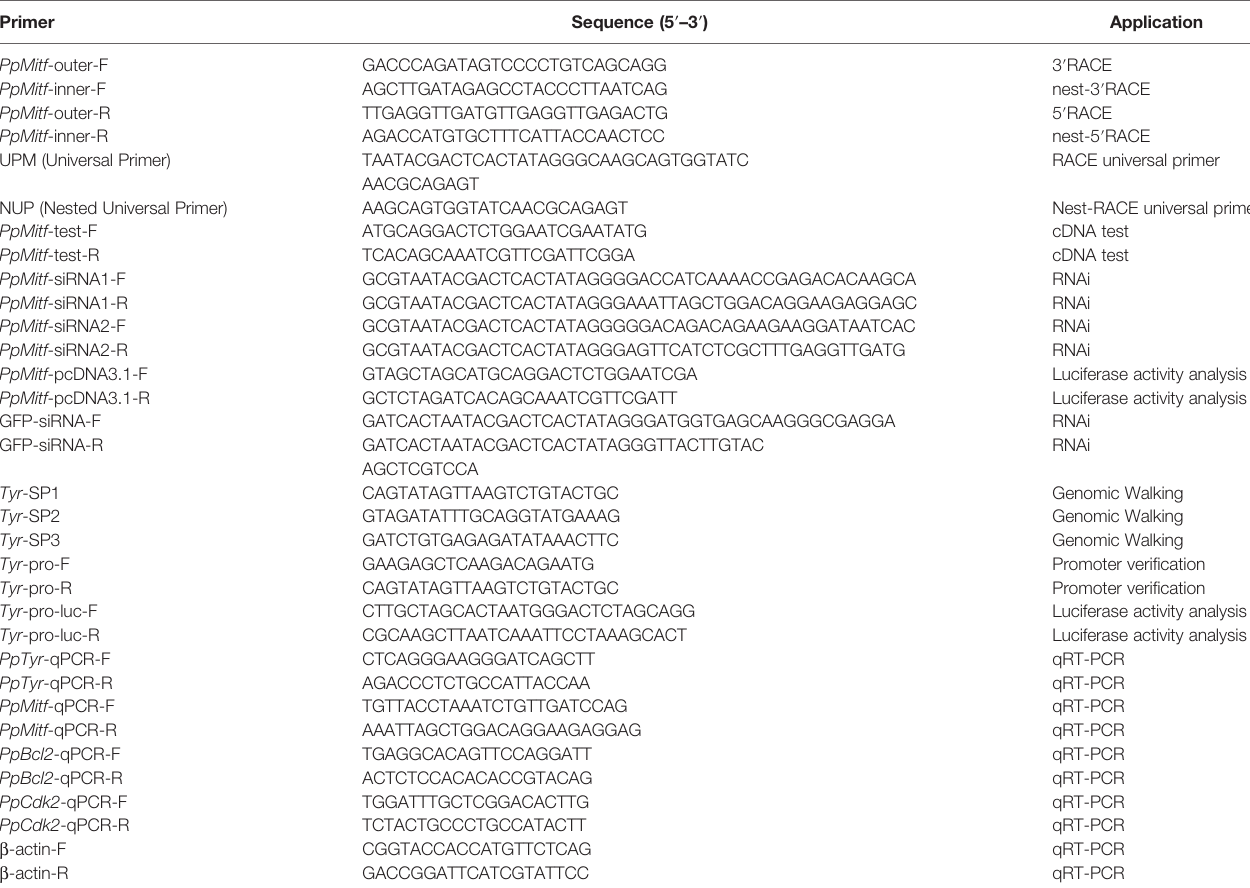
TABLE 1 | Primers used in the